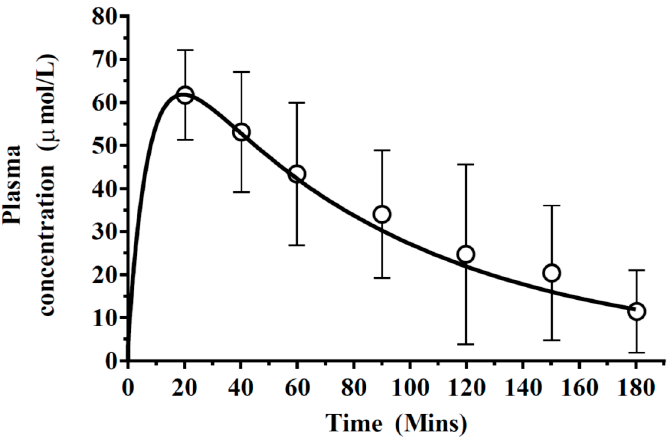
Figure 4. Simulated mean phenytoin plasma concentration–time profiles. A 50 mg/kg phenytoin dose was simulated (solid line) with reported literature data, represented by open circles with error bars representing standard deviations.